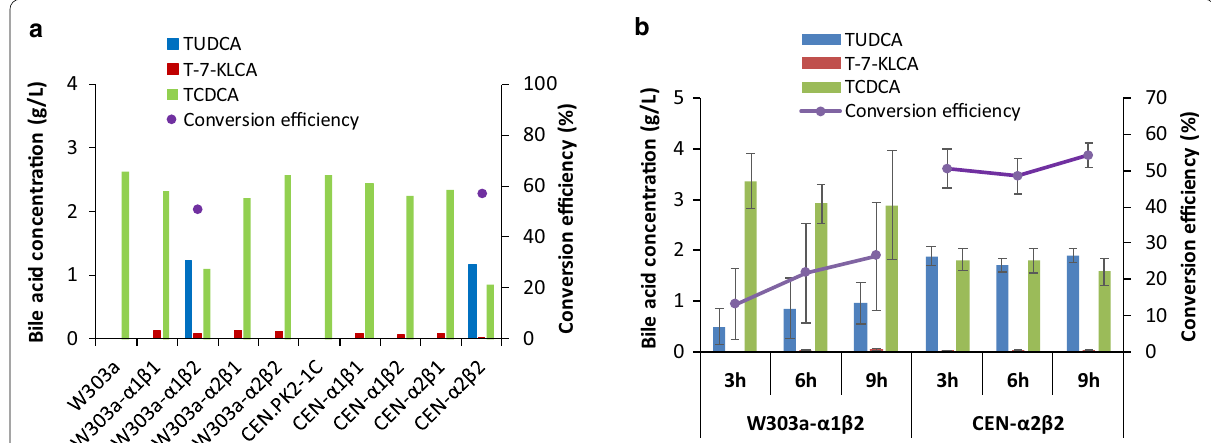
Fig. 2 Results of high productive engineered Saccharomyces cerevisiae screening. a Results of eight engineered yeast strains and two control yeast strains under 30 °C, pH 6.5 for 6 h. b Results of W303a-α1β2 and CEN-α2β2 under 25 °C, pH